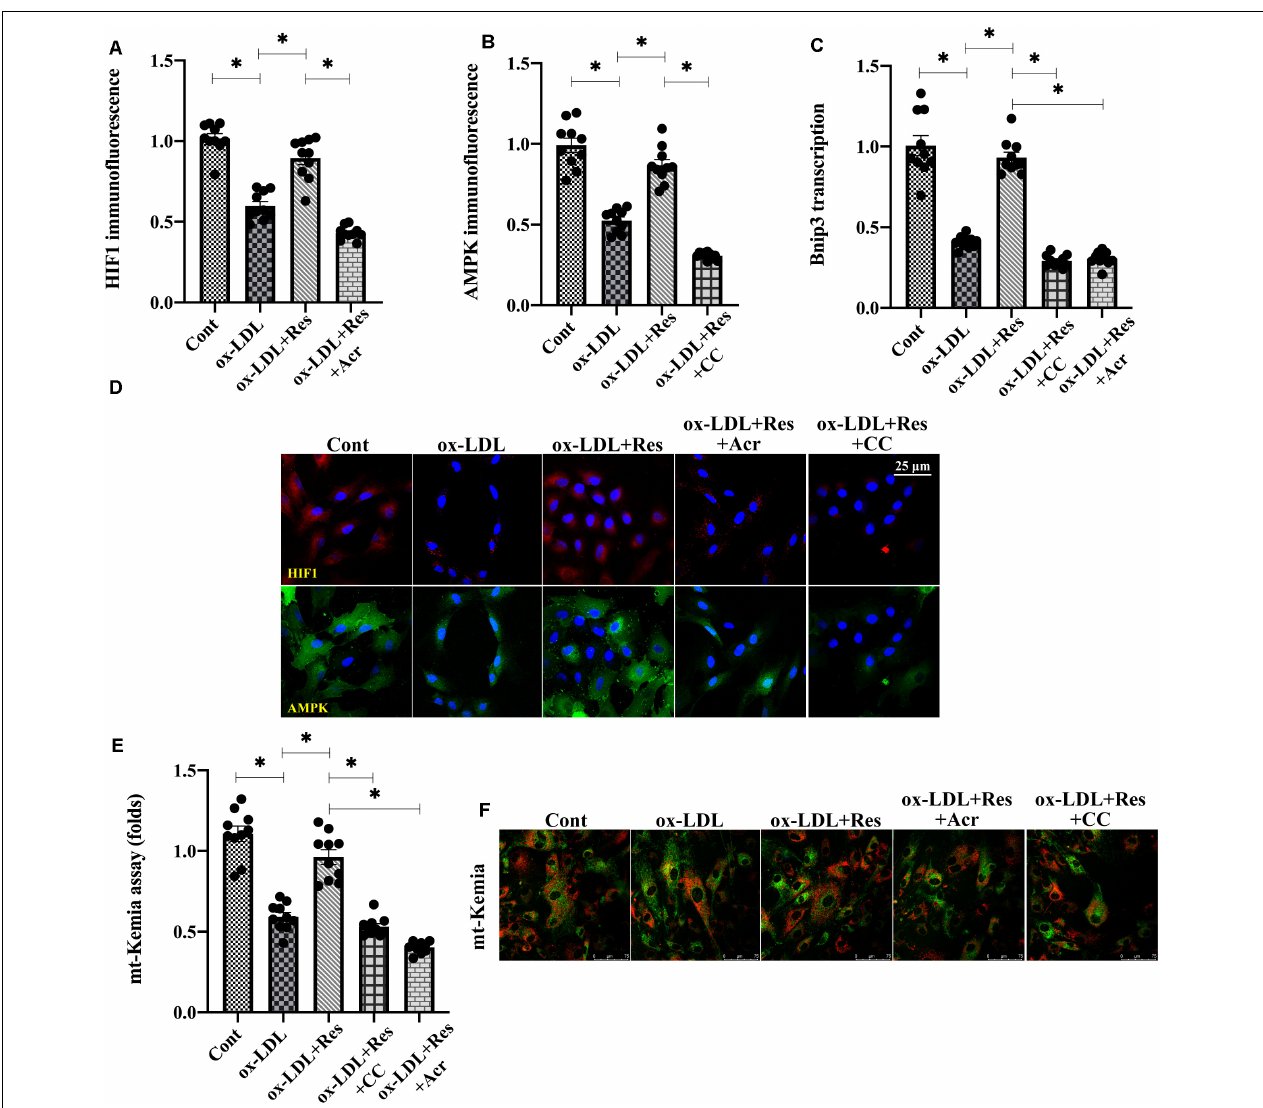
FIGURE 5 | Resveratrol regulates Bnip3 through the HIF1 and AMPK. (A–C) Immunofluorescence assay for HIF1 and AMPK in endothelial cells treated with ox-LDL in the presence or absence of resveratrol. Acriflavine (Acr) and compound c (CC), the antagonists of HIF1 and AMPK, respectively, were incubated with endothelial cells before resveratrol treatment. (D) qPCR was used to determine the Bnip3 alteration in endothelial cells treated with ox-LDL, resveratrol, Acr, or CC. (E,F) Endothelial mitophagy was detected through mt-Kemia. The acid mitochondria number was recorded to reflect mitophagy activity. * p <